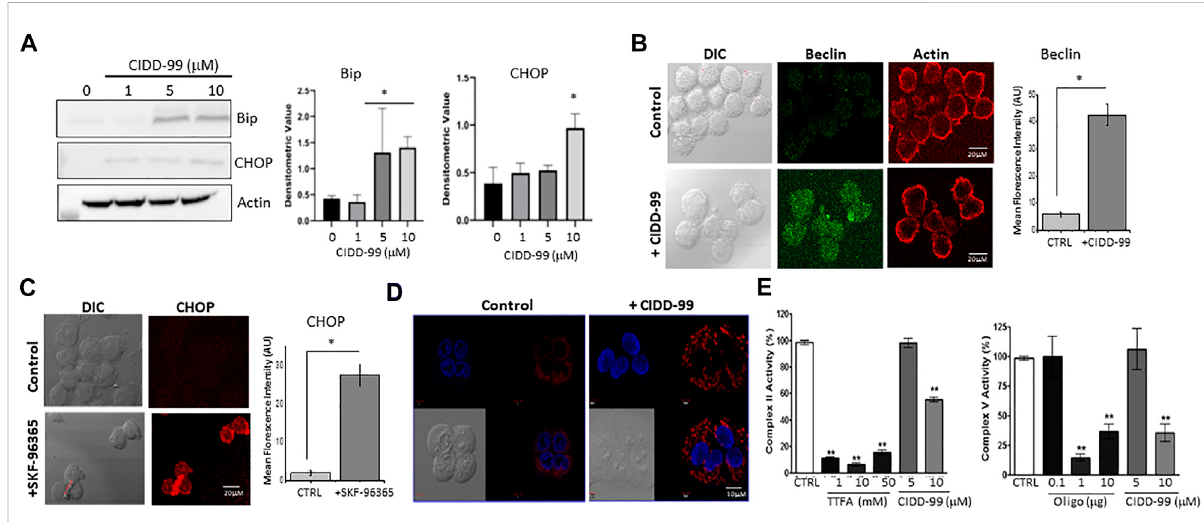
OSCC cells treated with CIDD-99 suffer ER stress and mitochondrial disfunction. (A) Cal-27 cells were treated with CIDD-99 at various concentrations as labeled for 24 h, lysed, and analyzed for ER stress markers. Quanti fi cation ( n = 3) of Bip is shown as bar graph and * indicates signi fi cantly different (using one-way ANOVA) from control untreated cells p < 0.05. (B) Representative confocal images of Cal-27 cells showing expression of Beclin-1 in control and CIDD-99 treated cells, actin was used as control. Bar graph shows quanti fi cation and * indicates signi fi cance ( p < 0.01 using one-way ANOVA) when compared with control. (C) Confocal images showing CHOP expression in control and SKF- 96365 treated Cal-27 cells, bar graph represents quanti fi cation, * indicates signi fi cance ( p < 0.01 using one-way ANOVA) when compared with control untreated. (D) Mito-tracker red staining shows mitochondrial morphological changes when treated with CIDD-99 for 2 h compared to the vehiclecontrol.MitochondrialactivitywasanalyzedusingMitocheckassayshowingtheeffectofCIDD-99oncomplexIIandcomplexV (E) inbovine cardiac mitochondria. Bar graph shows quanti fi cation and ** indicates signi fi cance ( p < 0.01 using one-way ANOVA) when compared with